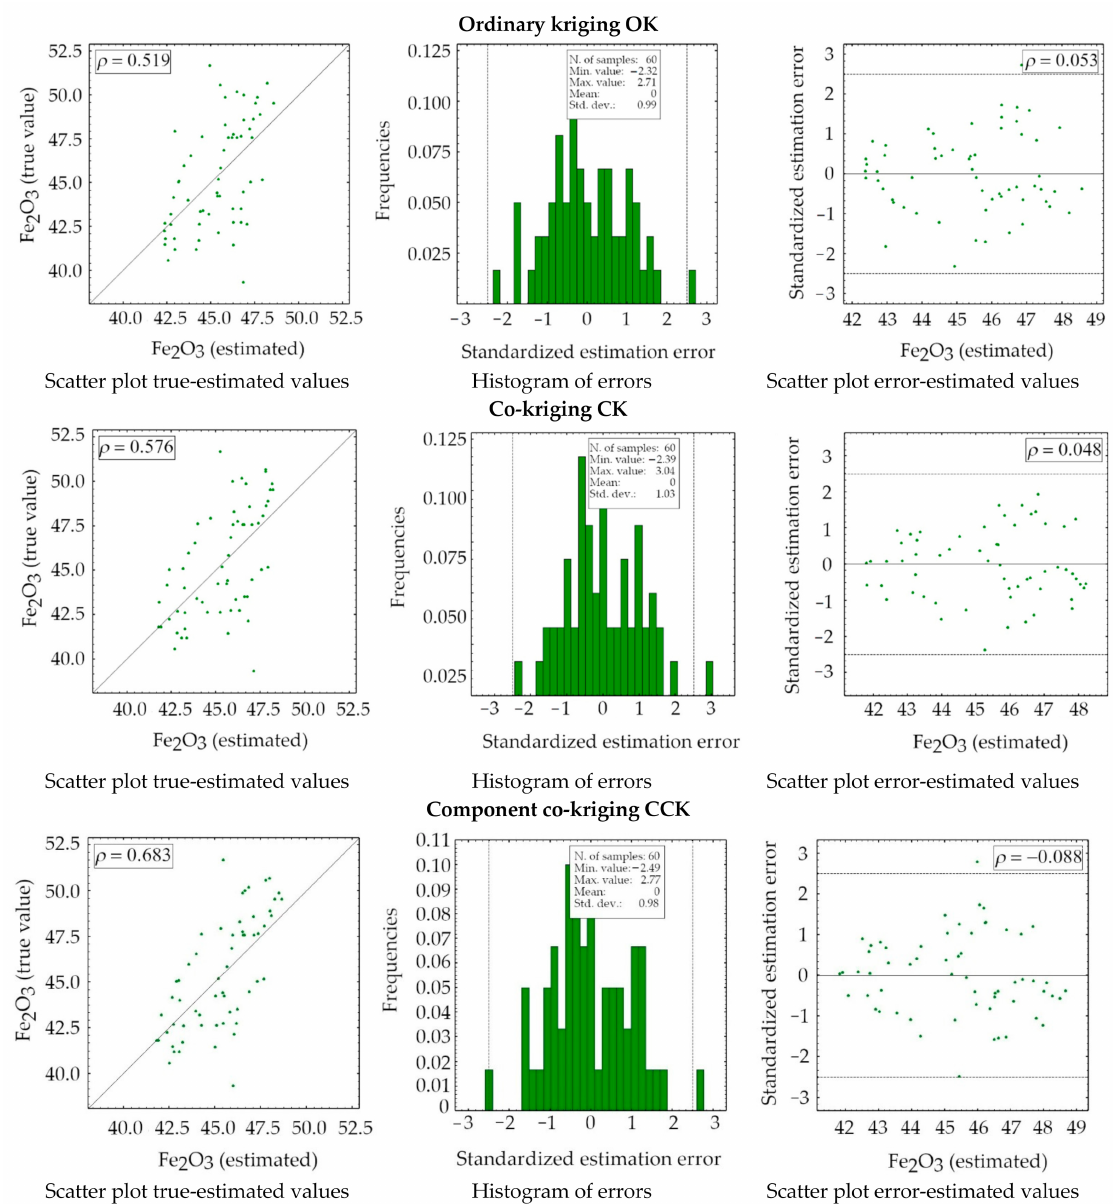
Figure 11. Statistics of cross-validation for OK , CK , and CCK results: scatter plot between true values of Fe 2 O 3 (%) at 60 sample points and estimated values ( left ), standardized estimation error ( central ), and scatter plot between error and estimated values ( right